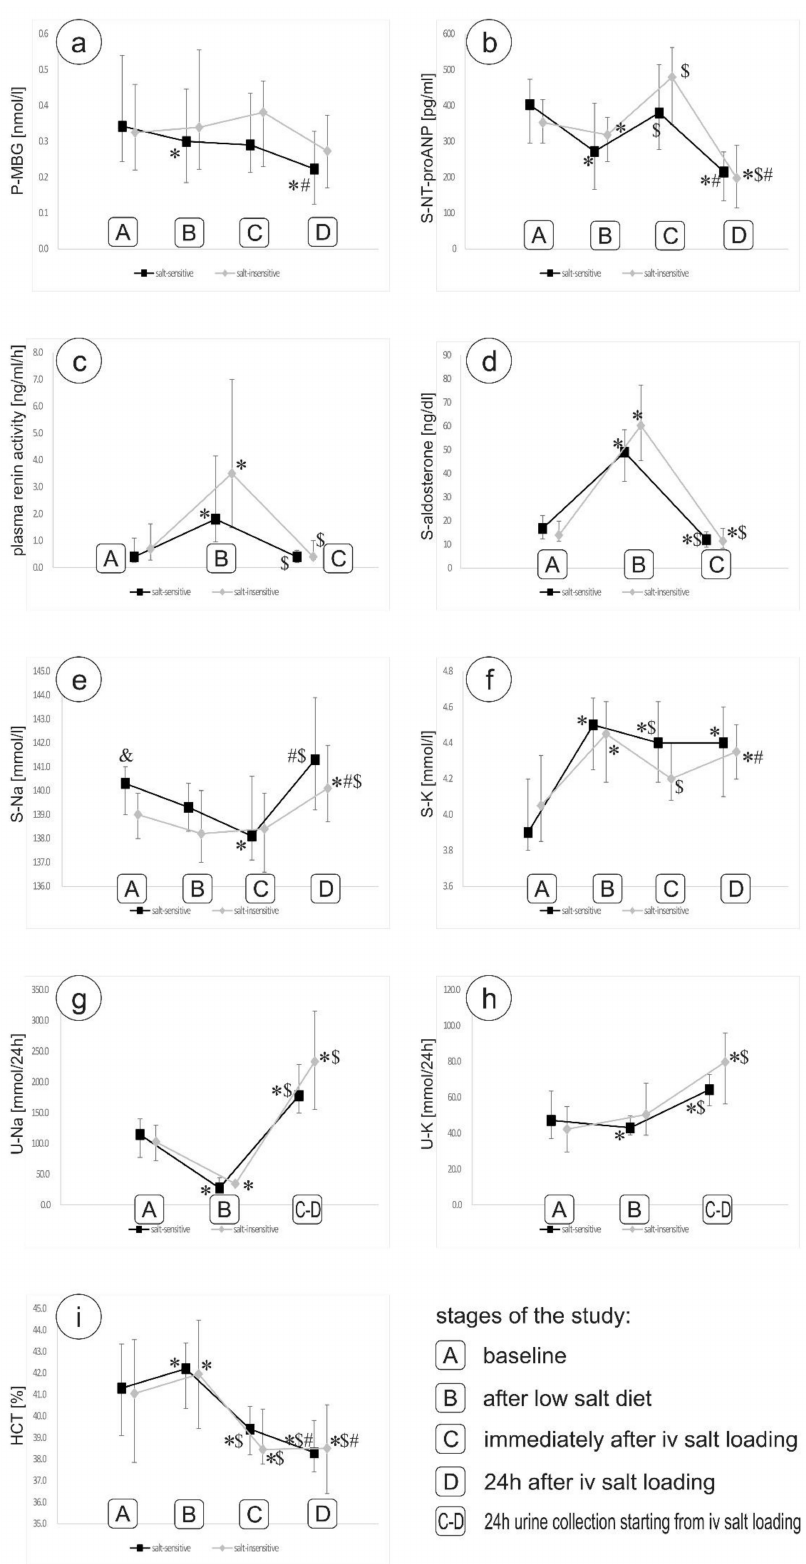
Figure 2. Changes in plasma MBG concentration ( a ) and serum NT-proANP ( b ) concentrations, PRA ( c ), serum aldosterone ( d ), sodium ( e ) and potassium ( f ) concentrations, urinary sodium ( g ) and potassium ( h ) excretion, and hematocrit ( i ), throughout the study. * p < 0,05 vs. stage A; $ p < 0,05 vs. stage B; # p < 0,05 vs. stage C; and & p < 0.05 between